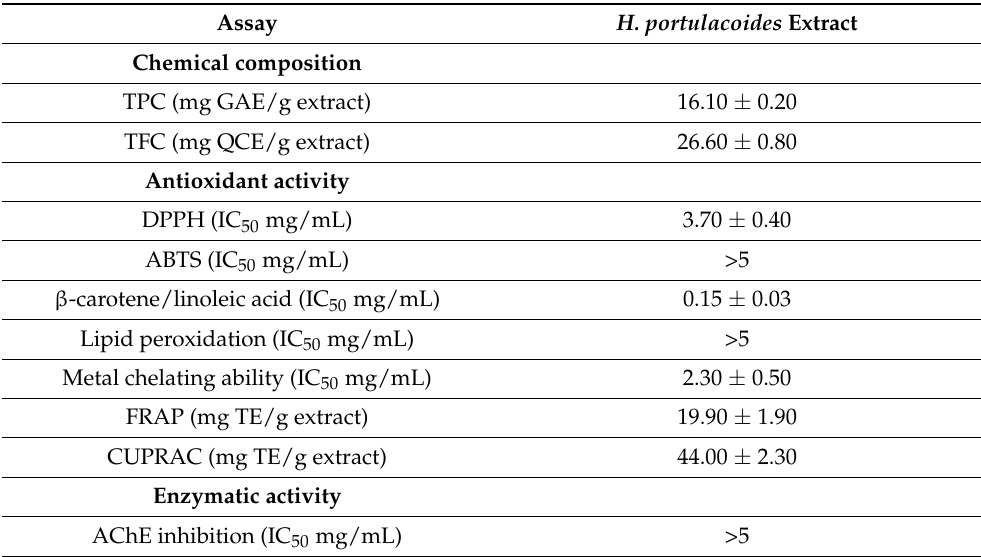
Table 4. Chemical composition and antioxidant and enzymatic activities of the H. portulacoides leaves